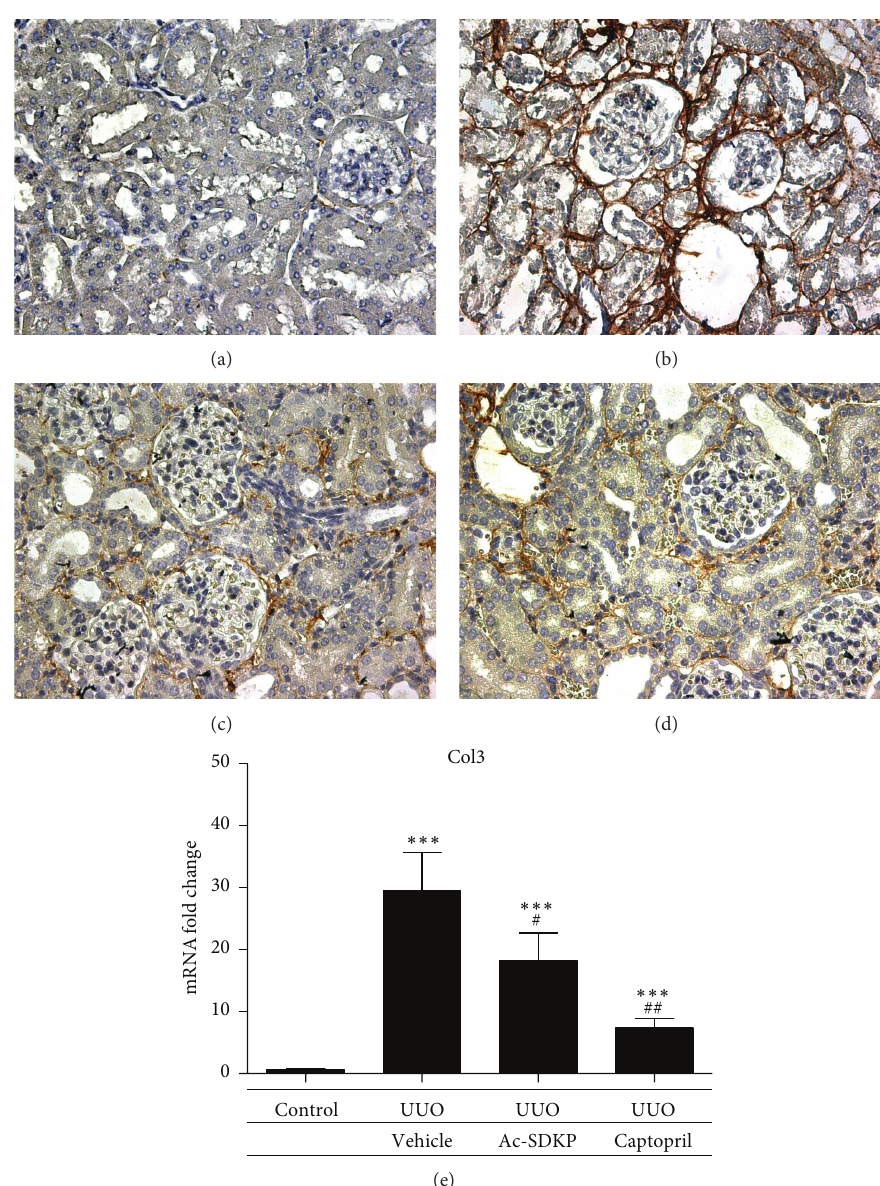
Figure 7: Collagen III expression in renal cortical tissue. (a–d) Representative immunohistochemical staining of protein expression from control animals (a), UUO operated animals (b), UUO animals with Ac-SDKP treatment (c), and UUO animals with Captopril treatment (d). Magnification (400x). (e) Quantitative analysis of mRNA expression by